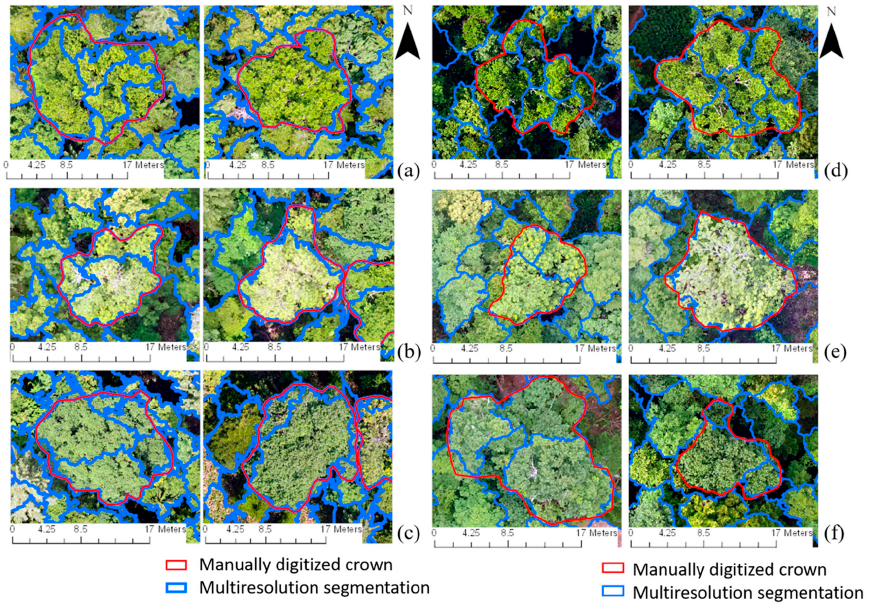
Figure 3. Individual tree crown results derived from multiresolution segmentation for three high-value timber species: ( a ) monarch birch, ( b ) castor aralia, and ( c ) Japanese oak in sub-compartment 36B; ( d ) monarch birch, ( e ) castor aralia, and ( f ) Japanese oak in sub-compartment 59A.